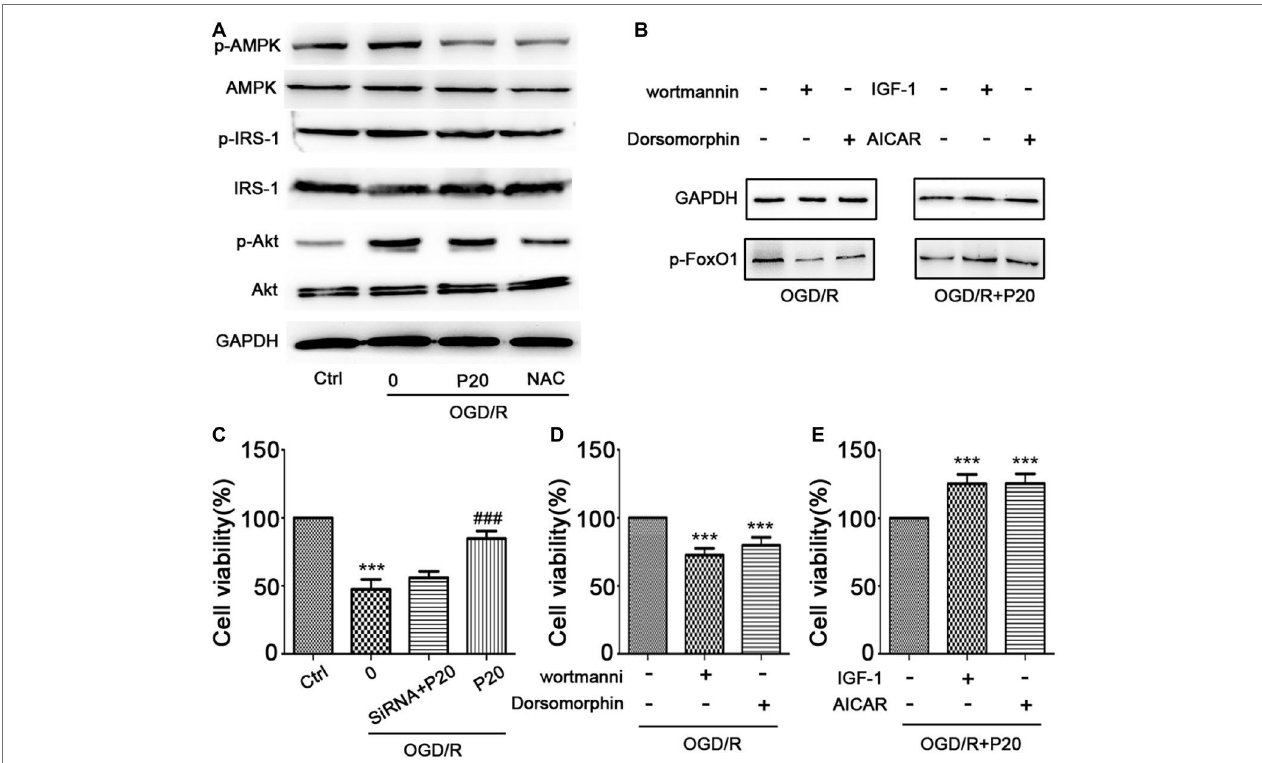
FIGURE 6 | Propofol inhibited FoxO1 phosphorylation through Akt and AMPK pathways. (A) The expression of proteins in FoxO1-related pathways in H9c2 cells. (B) The expression of p-FoxO1 after being treated with inhibitors and activators of Akt and AMPK pathways. (C) Cell viability was assessed by MTT assay after FoxO1 siRNA transfection in H9c2 cells. (D–E) Cell viability was assessed by MTT assay after being treated with inhibitors and activators of Akt and AMPK pathways. The data are presented as the mean ± SD of three independent experiments. * p < 0.05, ** p < 0.01, *** p < 0.001 versus control, # p < 0.05, ## p < 0.01, ### p < 0.001 versus OGD/R treated group without drugs.